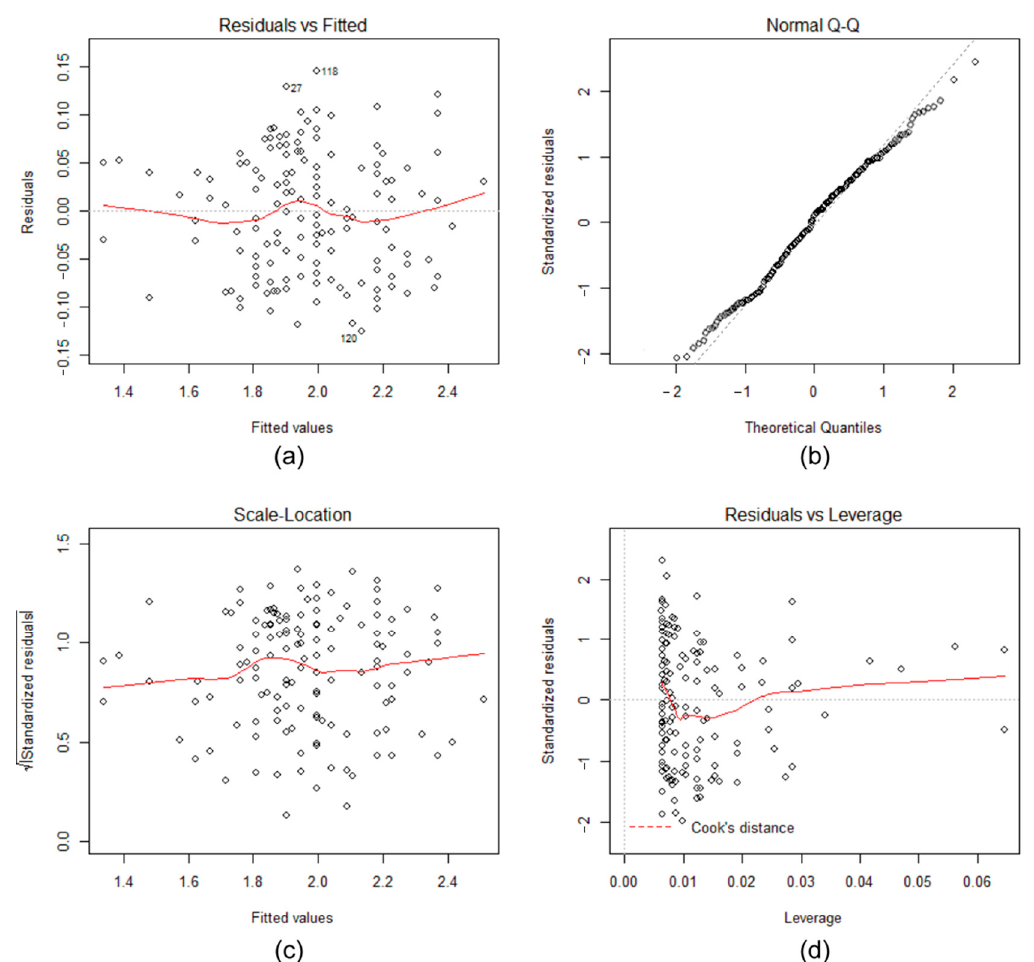
Figure 9. Residual analysis of the linear model of UAV estimated and on-ground measured vine heights: ( a ) residuals vs. fitted values, ( b ) normality of residuals, ( c ) scale–location, and ( d ) leverage vs. residuals.